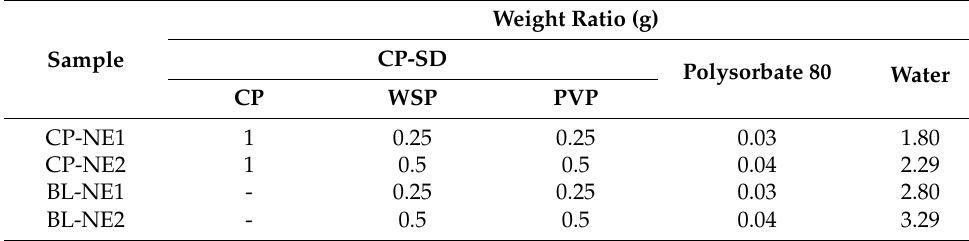
Table 2. Composition of